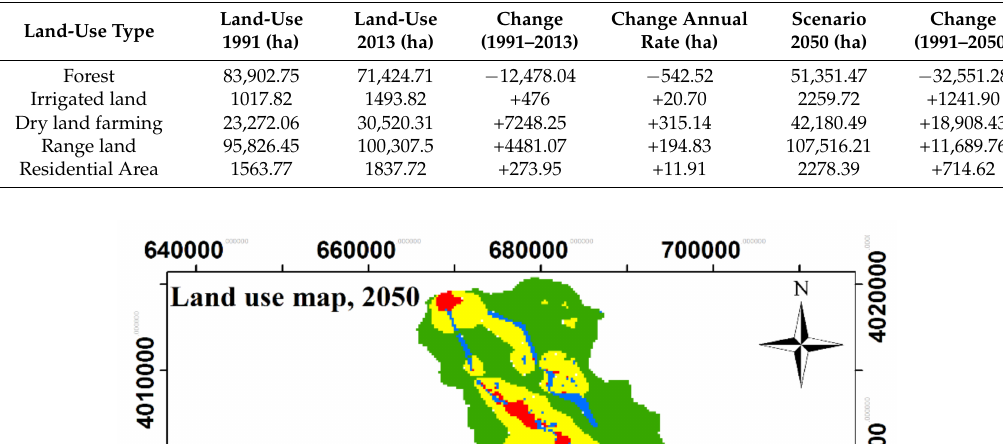
Table 6. Land use changes from 1991 to 2013 and the 2050 scenario.